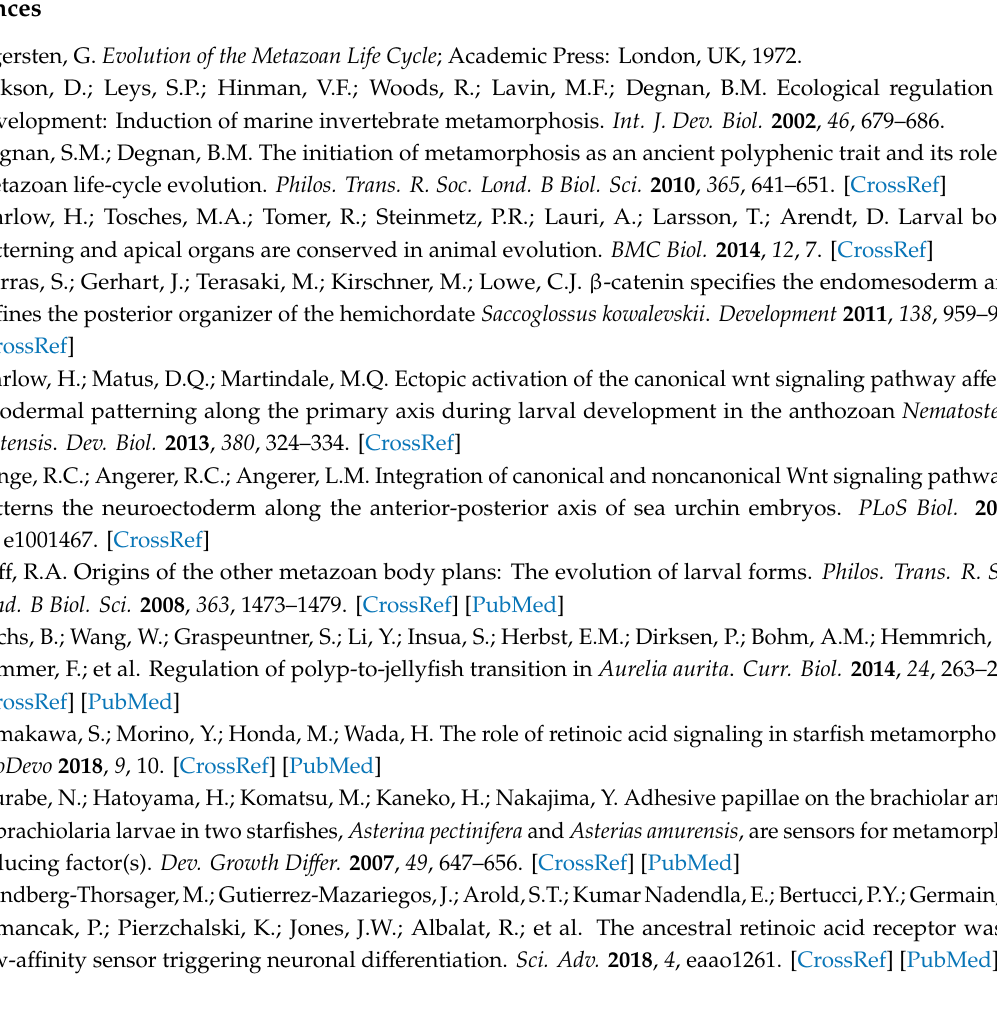
Figure S1: The phylogenic tree of ALDH gene family. Figure S2: The phylogenic tree of RAR, RXR and THR (Thyroid hormone receptor). Figure S3: Temporal change of larvae in metamorphosis induction by exogenous RA treatment. Table S1: The accession numbers of sequences for phylogenetic analysis. Table S2: Number of metamorphosed / treated larvae of each batch in substrate treatment experiment. Table S3: Number of metamorphosed / treated larvae of each batch in RA treatment experiment. Table S4: Number of settled or metamorphosed / treated larvae of each batch in DEAB or RO treatment experiment. Table S5: Number of metamorphosed / treated larvae of each batch in RA + RO treatment experiment. Supplementary dataset 1: The sequences for phylogenetic analysis of Raldh. Supplementary dataset 2: The sequences for phylogenetic analysis of RAR and